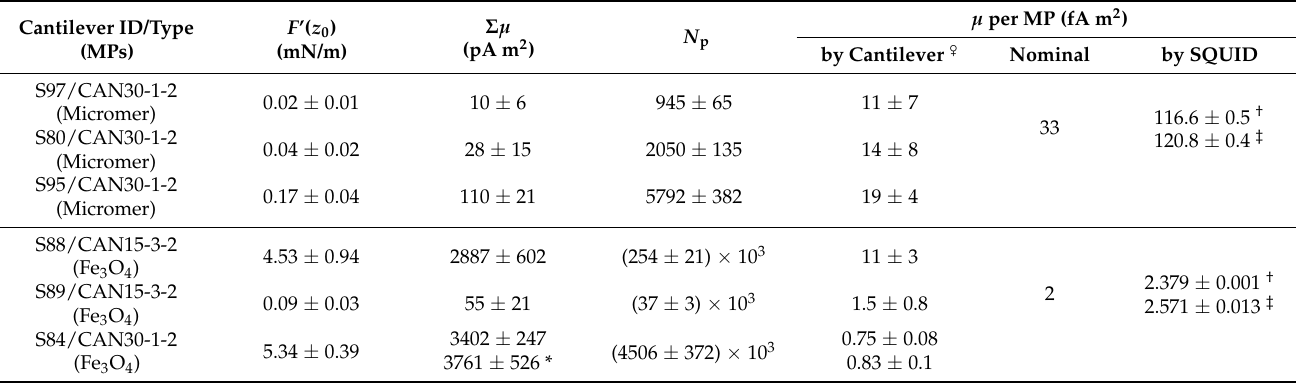
Table 4. Magnetic force gradient (under 2 mm magnets spacing) and derived magnetic moment per magnetic particle. Cantilever ID/Type (MPs)